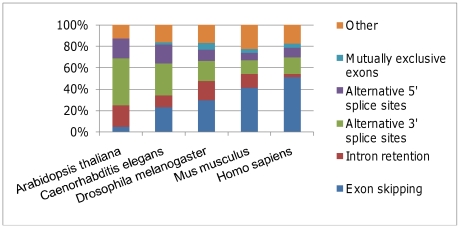
Relative frequency of alternative splicing (AS) types in five
species.The category “Other” includes complex schemes of AS, e.g.
simultaneous occurrences of alternative 5′ and 3′ splice
sites within an intron.